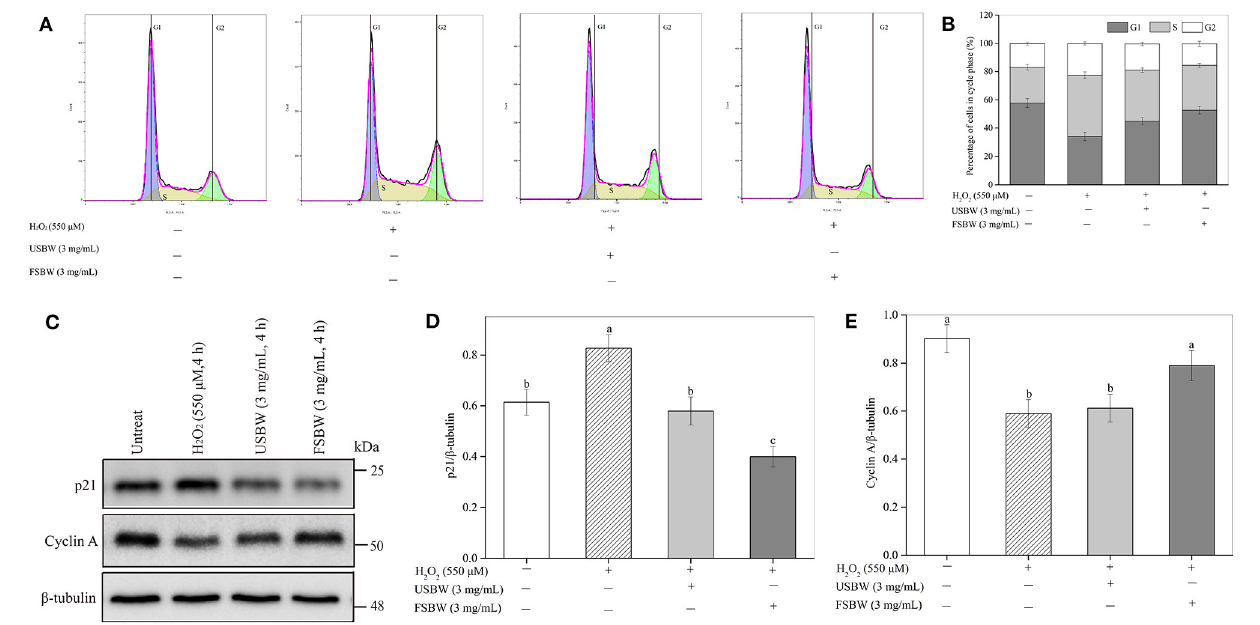
FIGURE 5 | Influence of USBW and FSBW in H 2 O 2 -induced cell cycle arrest. (A) Cell cycle detected using a flow cytometer; (B) Statistical histogram in (A) ; (C) Cyclin A and p21 levels; (D,E) Statistical histogram in (C) . p < 0.05 was considered as the significant level. The small letters were used to indicate the significant difference and the ordering of